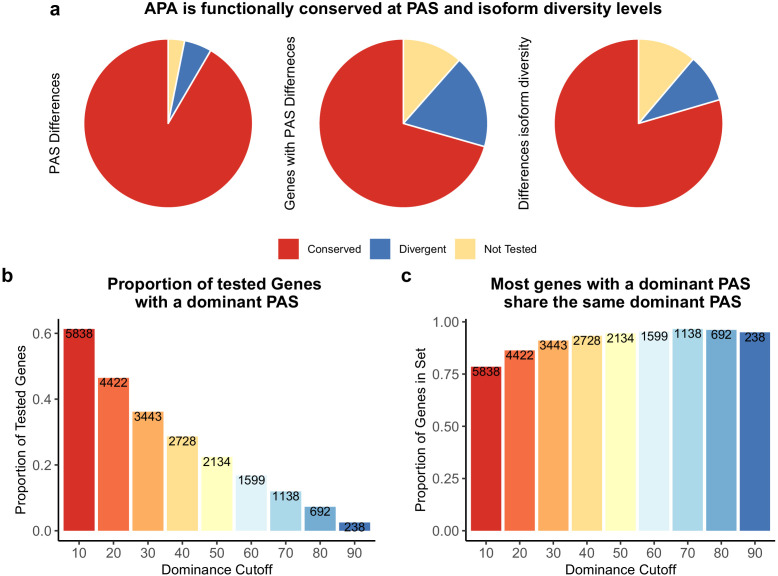
Alternative polyadenylation (APA) is functionally conserved in both species.(a) Proportion of polyadenylation sites (PAS) and genes differentially used at PAS and isoform diversity level. (Left) Divergent PAS are the 2342 PAS differentially used at 5% FDR. Conserved are the PAS not differentially used at 5% FDR. Not tested PAS were removed from analysis by leafcutter tool. (Middle) PAS level differentially used PAS reported at the gene level. Divergent genes are the 1705 genes with PAS differentially used at 5% FDR. Conserved genes are the genes with no PAS differentially used at 5% FDR. (Right) Divergent genes are the 881 genes with differences in isoform diversity between species at a 5% FDR. Conserved genes are genes without differences in isoform diversity. Genes with one PAS were not tested. (b) Proportion of tested genes with a dominant PAS in either species according to a range of cutoffs. Number of genes are reported in bars. The bars are colored by the dominance cutoff on the X axis. (c) Proportion of the number of genes with a dominant in either species that share the top used PAS according to each dominance cutoff. Number of genes with a dominant PAS in either species are reported in bars. The bars are colored by the dominance cutoff on the X axis.